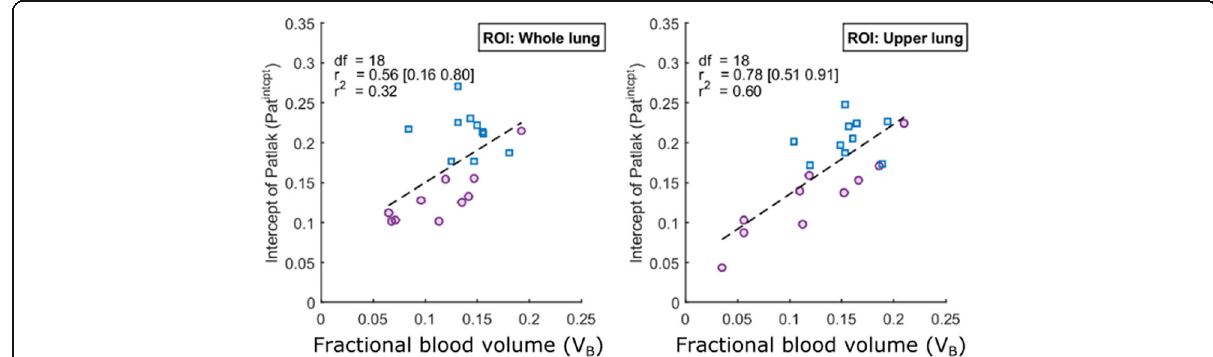
Fig. 6 Scatter plot showing the relationship between the intercept of the graphical Patlak analysis ( Pat intcpt ) and the fractional blood volume ( V B ). Left whole lung, Right upper lung, Blue squares HV, violet circles